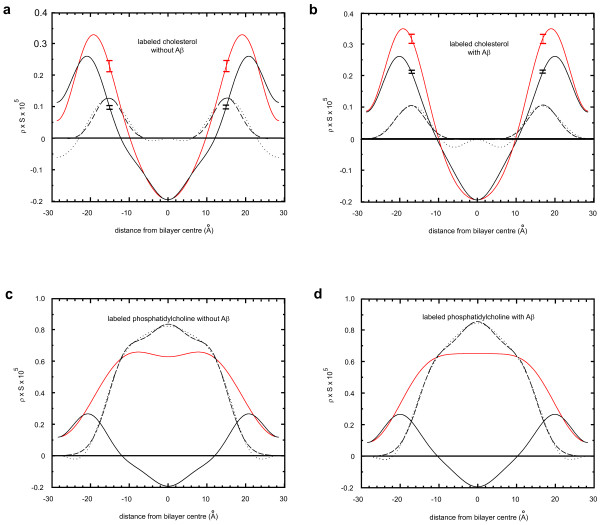
Displacement of membrane cholesterol by Aβ(1–42) oligomers. Panels a and b illustrate how the positions of the labels in deuterated Chol were determined, in the presence and absence of Aβ(1–42), respectively. The solid black lines are the SLD profiles obtained with unlabelled Chol, and the solid red lines are the profiles with labelled Chol. The dotted lines are the corresponding difference (plus or minus peptide) profiles, and the dashed lines are best-fit single Gaussian fits to these difference profiles, showing peaks at 15.11 ± 0.39 Å from the bilayer centre (without peptide), and 17.06 ± 0.26 Å from the bilayer centre (with peptide), respectively (mean mid-peak positions ± SD). The errors bars show the 95% confidence intervals of the SLD profiles at the mid-difference profile positions. Panels c and d show similar difference profiles and fits without and with membrane Aβ(1–42) for the uniformly-labelled palmitoyl acyl chains of POPC, with similar figure labelling.